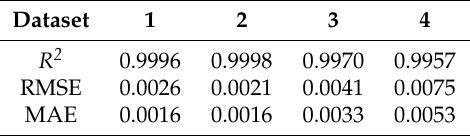
Figure 10. FNN predicted fine fraction along the depth (z-direction): ( a ) for datasets 1 and 2; ( b ) for datasets 3 and 4. Table 3. Statistical performances of FNN model (for testing data) along the depth